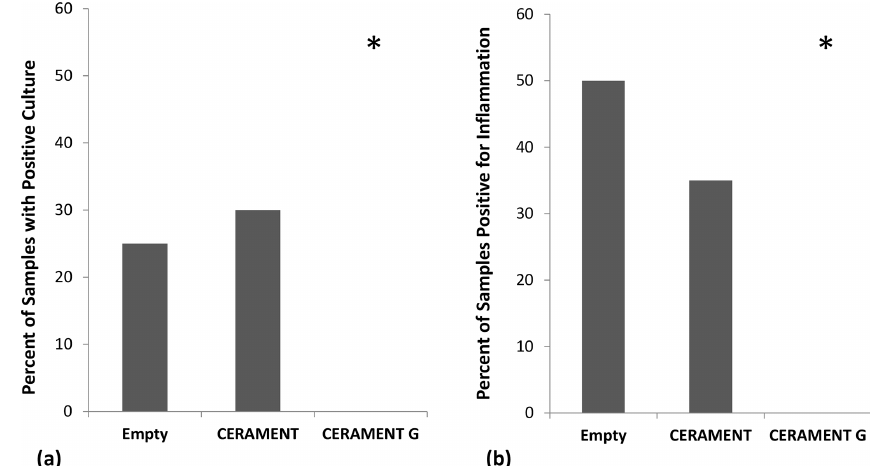
Figure 3. Detection of persistent infection: percentage of samples in each group positive for growth ( n = 20 per group). CERAMENT G inhibited bacterial growth in the osteomyelitic defect as seen by the percentage of samples in each group that had positive growth on culture medium (a) and positive histological evidence of osteomyelitis (b) . * p < 0 . 05 using 2 × 3 contingency table and Fisher’s exact test.